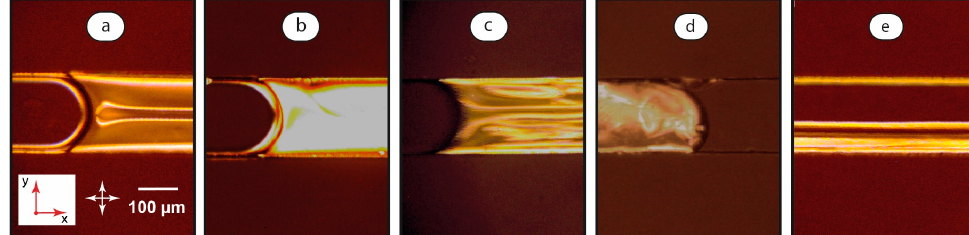
Figure 3. Polarized optical microscopy images of LC-water flows in a microchannel at various flow conditions: U = 0, φ = 10 ( a ), U = 0.05 mm/s, φ = 10 ( b ), U = 0.5 mm/s, φ = 10 ( c ), U = 0.5 mm/s, φ = 0.1 ( d ), and U = 2 mm/s, φ = 1 ( e ). Red arrows demonstrate coordinate axes with respect to Figure 1. Crossed white arrows indicate positions of polarizers.